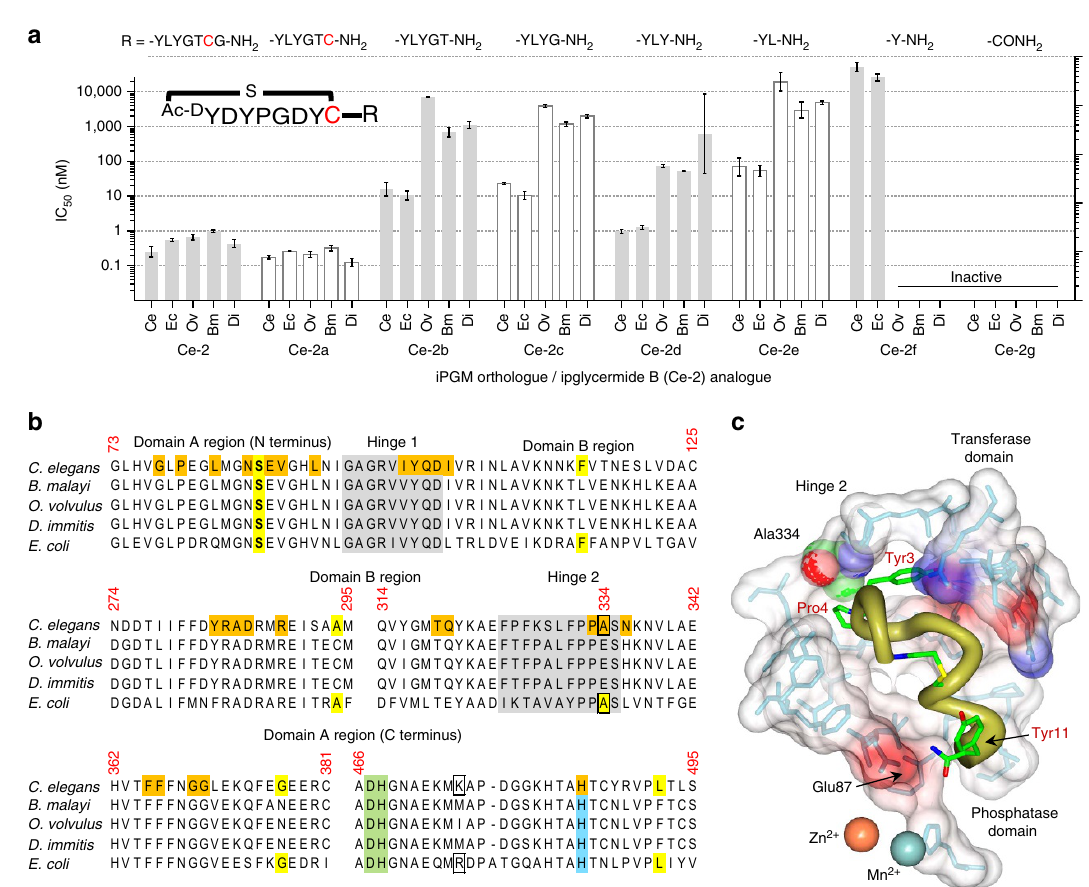
Figure 5 | Structural basis underlying the pharmacologic–phylogenetic Ce-2 macrocycle series-iPGM orthologue relationship. ( a ) Relationship between Ce-2 macrocycle truncation series IC 50 s and iPGM orthologues. Analogues with no detectable inhibitory activity are indicated as inactive. Data represent mean ± s.d. values of the log normal distributed IC 50 s determined for the given peptide for experiments with Z 4 replicates; otherwise error bar is determined from the nonlinear fit of the standard Hill equation to the aggregated data from the replicates. Values are from Supplementary Table 3 converted from pIC 50 where IC 50 ¼ 10 -pIC 50 . ( b ) Select amino-acid sequence alignment of iPGM orthologues in this study (see Supplementary Fig. 10 for full alignment). iPGM residues within 5Å of Ce-2d are coloured orange. Residues identical between C. elegans and E. coli iPGM are coloured yellow; grey indicated hinge regions; green and blue are amino acids that ligand metal ions. ( c ) Cavity formed from C. elegans iPGM residues (light blue chain under transparent spheres) within 5Å of the Ce-2d macrocycle shown as a worm a -chain (gold) representation scaled by B-factor with select side chains (Tyr3, Pro4, thioether linkage, and C-terminal Tyr11 amide) shown. The iPGM Ala334 residue is shown as a CPK space fill. Electrostatic surface of the Ce-2d binding cavity is also shown.